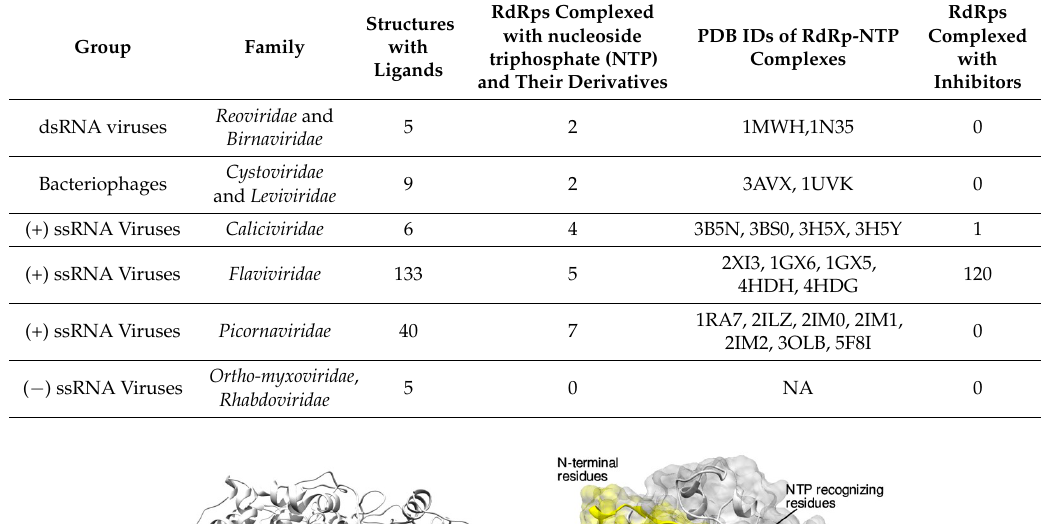
Table 2. Inhibitor and substrate complexes of RdRPs from different viruses (listed in Table 1) determined to a resolution better than 2.5 Å.